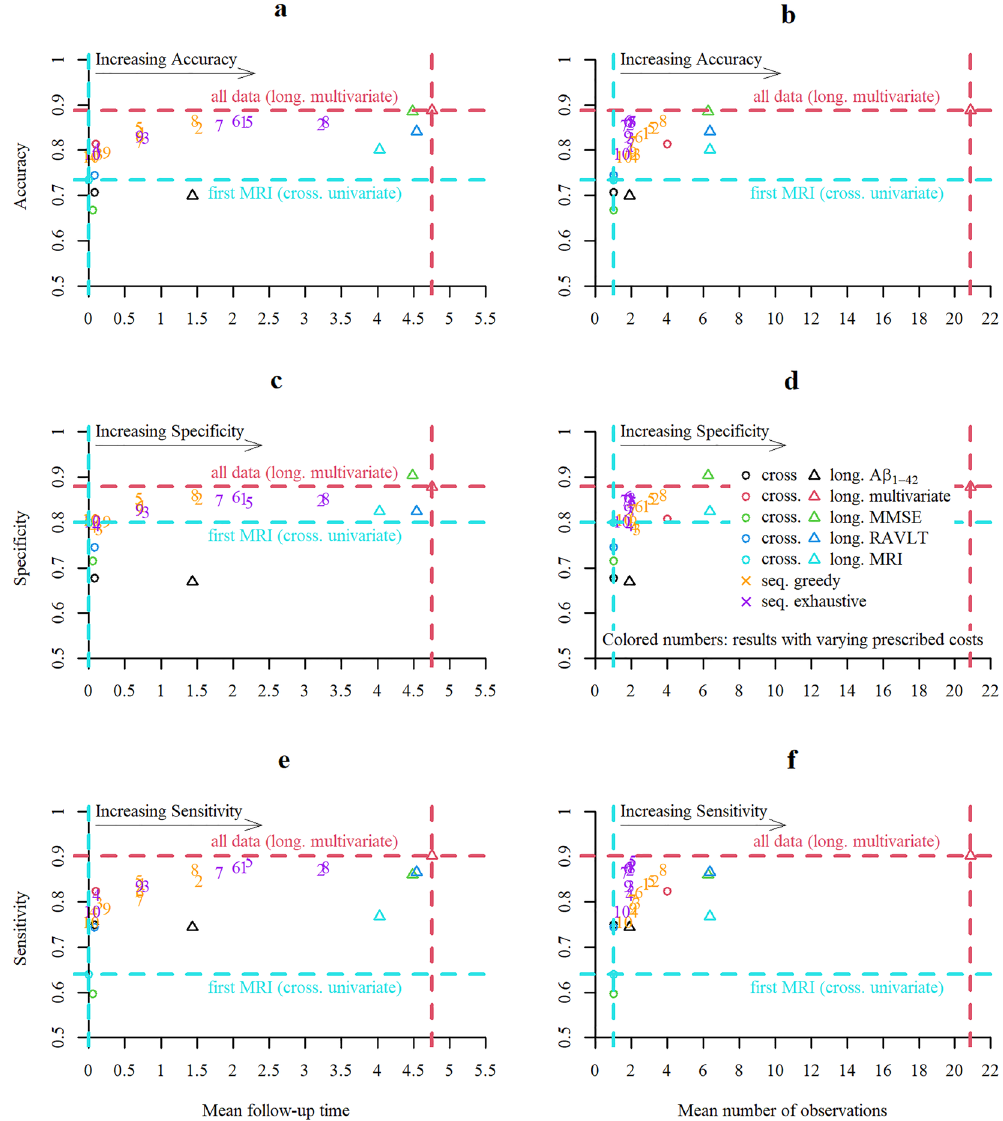
Figure 4. Sequential and non-sequential decision strategies. Quantitative comparison of sequential (for varying costs of acquisition and time, see below) and fixed i.e., univariate or multivariate cross-sectional (cross.) or longitudinal (long.) classification strategies. Note that the scale of the y-axes starts at 0.5 (chance level) and not at 0 (minimum possible value). Mean follow-up time or mean number of observations and resulting accuracy (in a and b ), specificity (in c and d ) or sensitivity (in e and f ) are displayed. Scattered numbers 1 to 10 in the plot correspond to results obtained with tuples of prescribed costs (time; MRI; Aβ 1-42- CSF ; cognitive test); 1: (2; 2; 4; 1), 2: (1; 2; 4; 1), 3: (4; 2; 4; 1), 4: (8; 2; 4; 1), 5: (2; 1; 2; 0.5), 6: (2; 4; 8; 2), 7: (2; 8; 16; 4), 8: (1; 1; 2; 0.5), 9: (4; 4; 8; 2)., 10: (8; 8; 16;